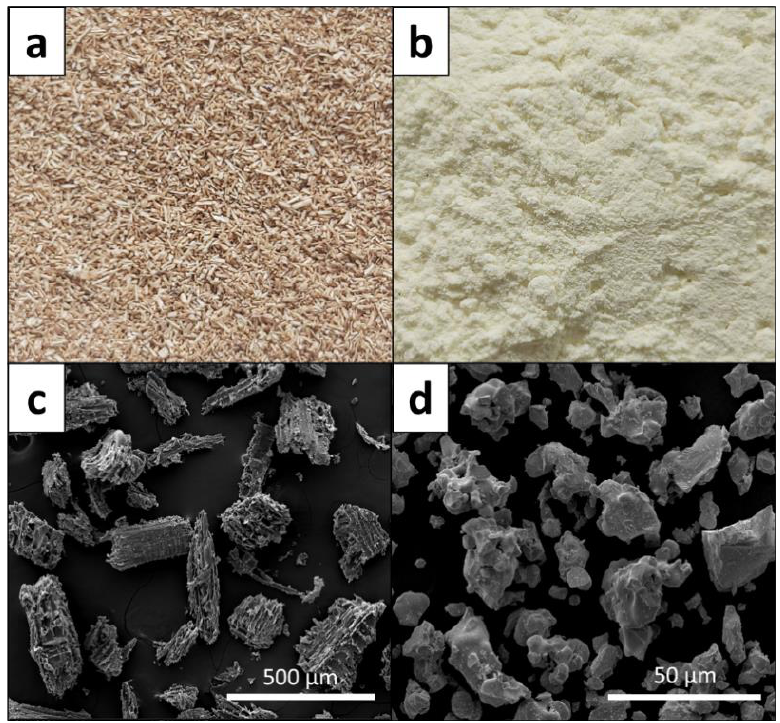
Figure 1. Optical images of ( a ) wood particles and ( b ) Bi 2 O 3 particles, and micrograph images of ( c ) wood particles and ( d ) Bi 2 O 3 particles.